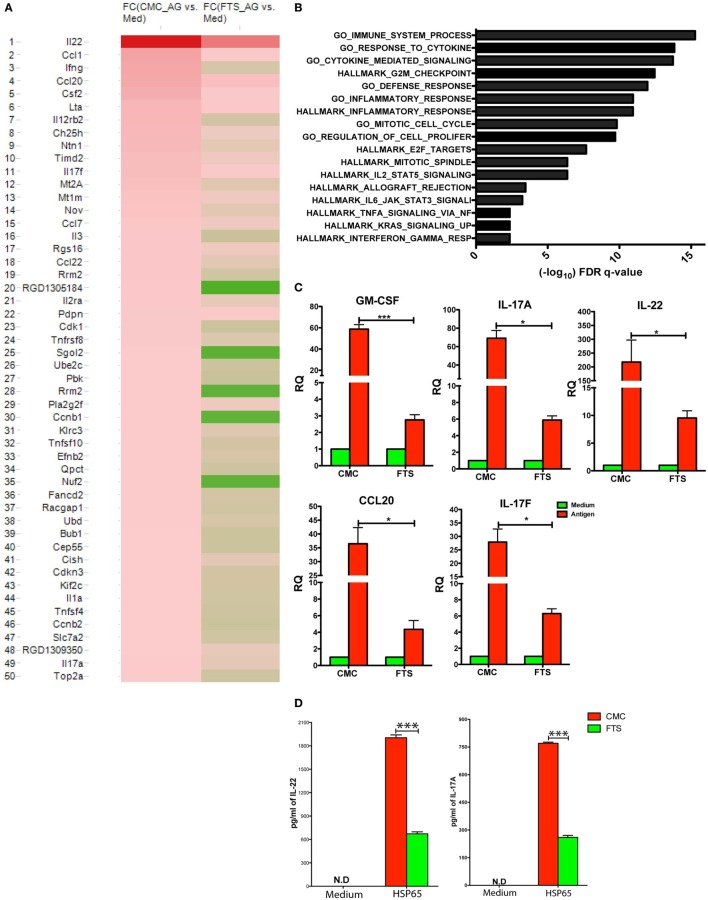
Farnesylthiosalicylic acid (FTS) therapy down modulates the Bhsp65-induced transcription of multiple genes tightly linked to inflammatory and immune processes. Following CFA-immunization, rats were treated with carboxymethyl cellulose (CMC) or FTS starting from day +1 post AIA induction. Single cell suspensions from draining LNs and spleen of treated rats (harvested on day +14 post disease induction) were stimulated with Bhsp65 (5 µg/ml) or control PBS and cultured for additional 72 h. At the end of cultures, CD4+ T cells were isolated and high quality total RNA was extracted from the purified cells. (A) Heat map analysis depicting the expression matrix of the 50 genes significantly induced by Bhsp65 stimulation (>2FC, FDR q < 0.05) in the CMC control group as compared to their expression in FTS treated group (n = 2 per group). In this two-color heat map, the brightest red and green colors represent the top up- or down-regulated mRNAs, respectively. (B) Next, we computed using the GSEA software web site v6.1 software, the overlaps between our gene list and relevant validated gene sets. Bars represent the FDR q-value (cutoff of <0.05) for the statistical significance of the overlap between the annotated Gene set and our list. (C) Purified total RNA was analyzed by quantitative PCR for the relative mRNA expression (normalized to Actb) of five inflammatory response genes (Ccl20, Il22, Il17A, Il17F, and Csf2) induced by Bhsp65 re-stimulation of CD4+ T cells treated in vivo with CMC vs. FTS. (D) Supernatants from the same cultures were tested by ELISA kits for levels of secreted 17A and IL-22 by readymade ELISA kits. Bar graphs depict mean ± SD, and statistical significance was analyzed by Student’s t-test (*P ≤ 0.05, **P ≤ 0.01, and ***P ≤ 0.001). Data shown are representative of a typical experiment out of n = 3.